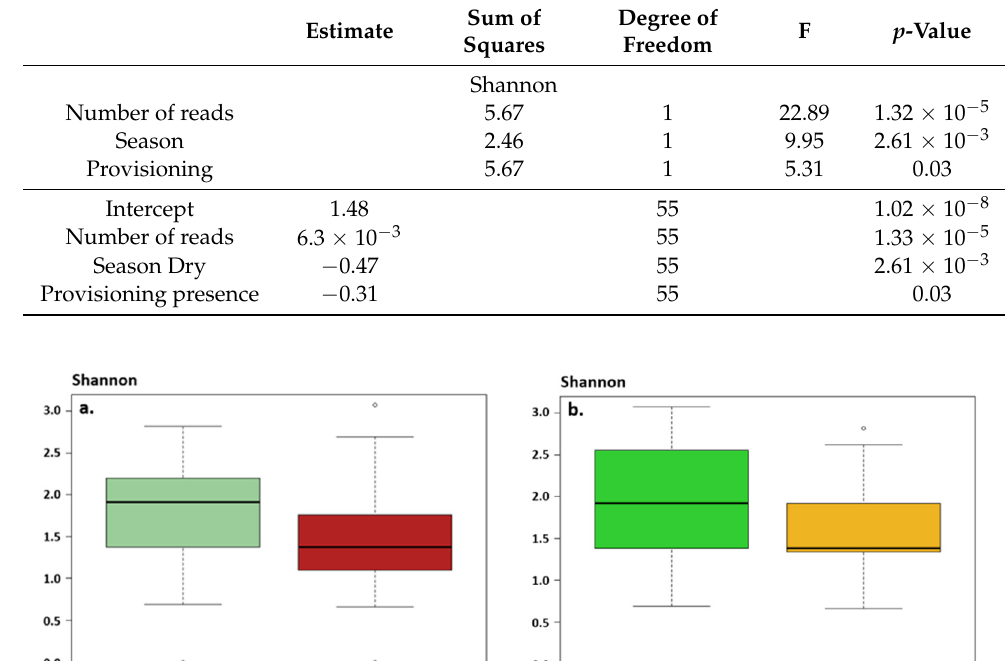
Table 2. Results for the selected LMM based on the Shannon index.